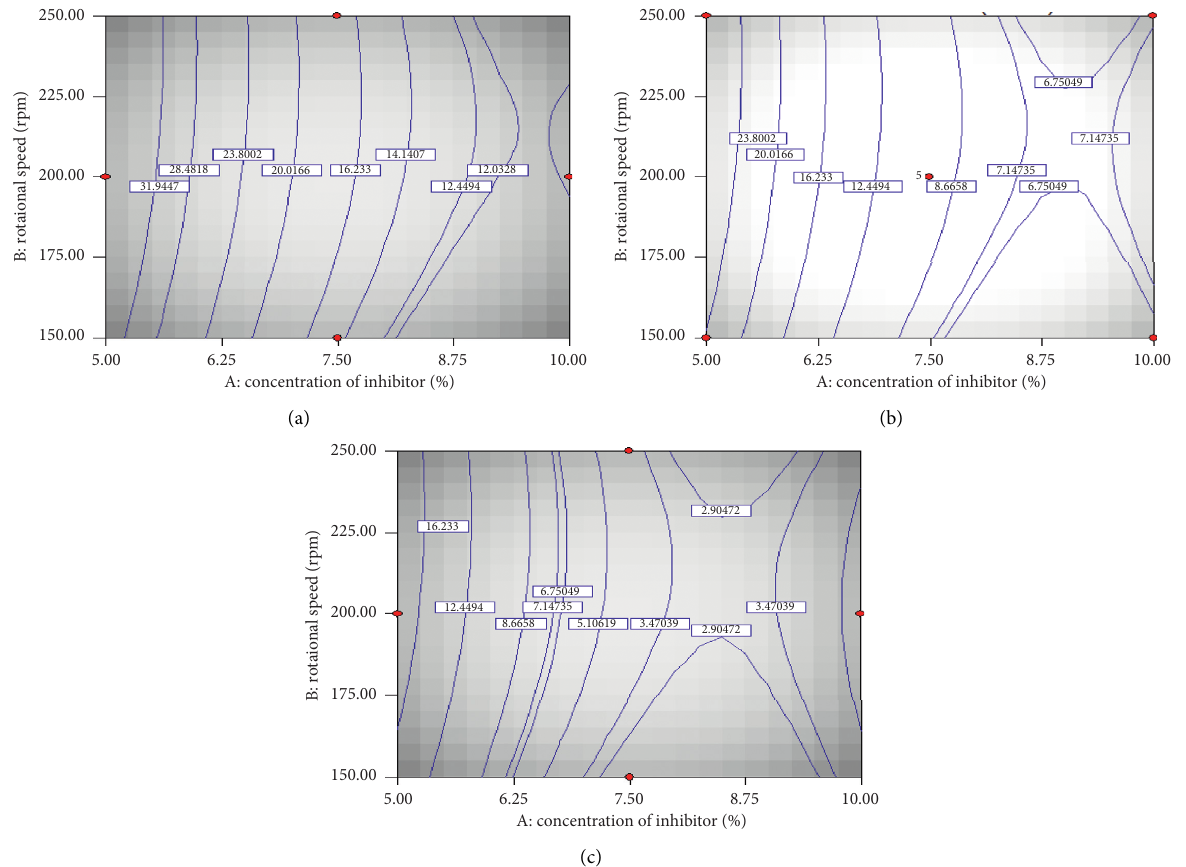
Figure 6: Contour plot of corrosion rate as a purpose of inhibitor load and rotational speed at the temperatures (a) 75 ° C, (b) 50 ° C, and (c) 25 ° C